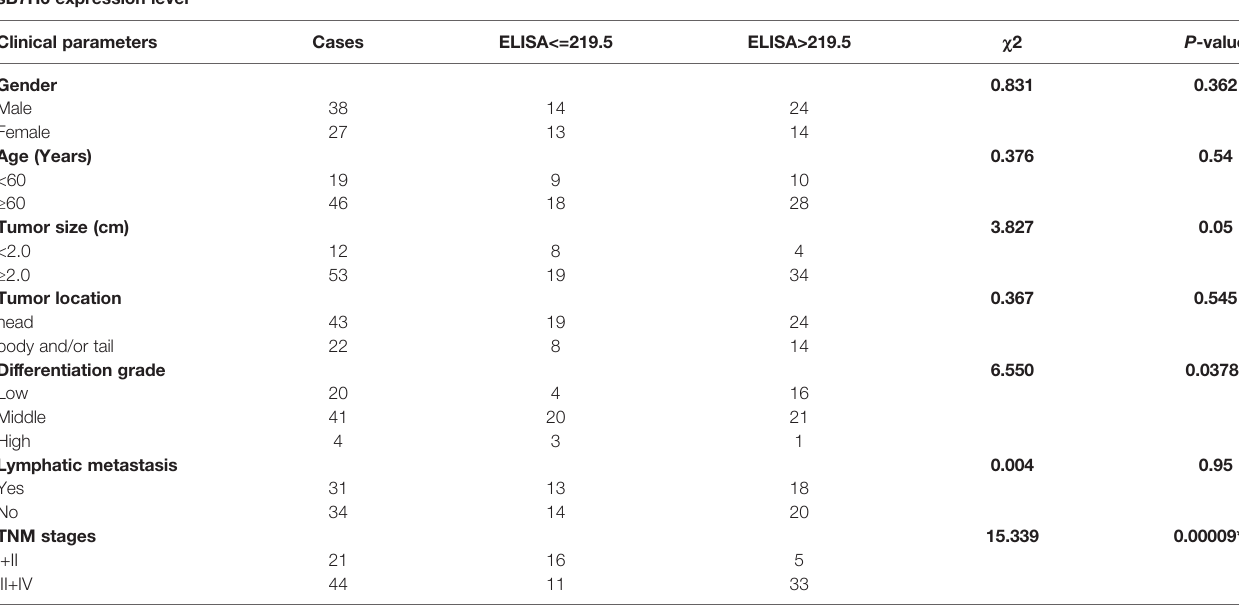
TABLE 2 | Clinical signi fi cance of sB7H6 expression. sB7H6 expression level Clinical